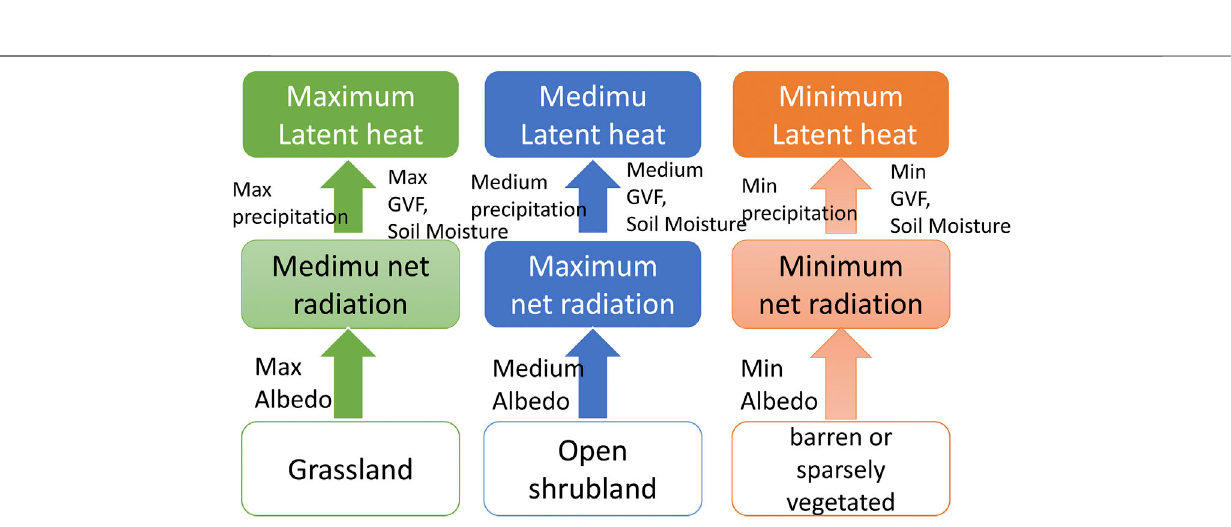
Frontiers in Earth Science |